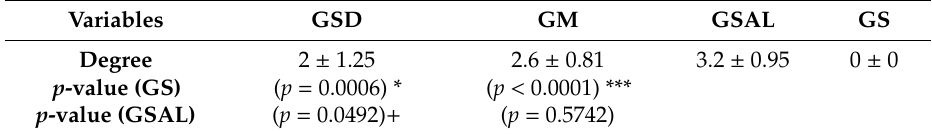
Table 4. Effect of crude extract of S . dulcis on articular cartilage.